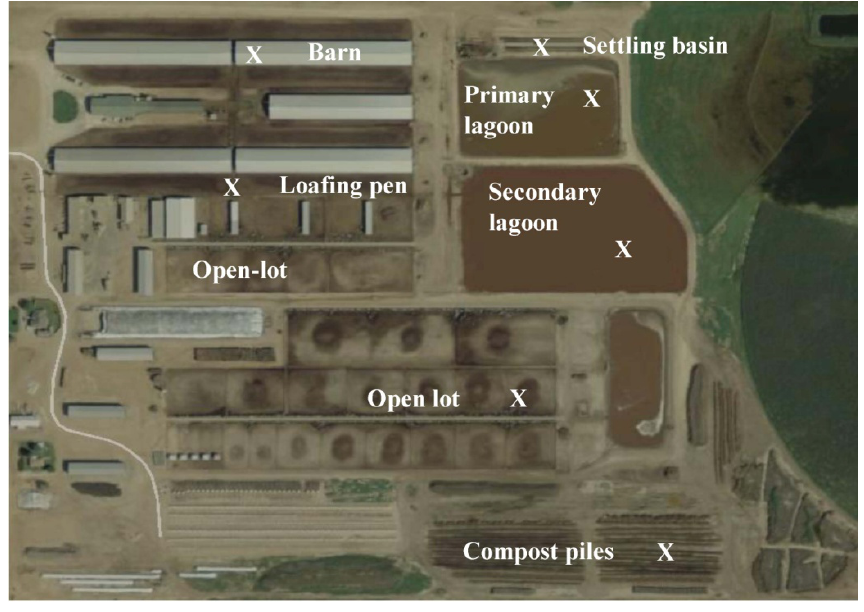
Figure 1. Aerial photograph of the dairy facility located at the Texas Panhandle. The sampling sites are marked with an “X”. (Photo from Google